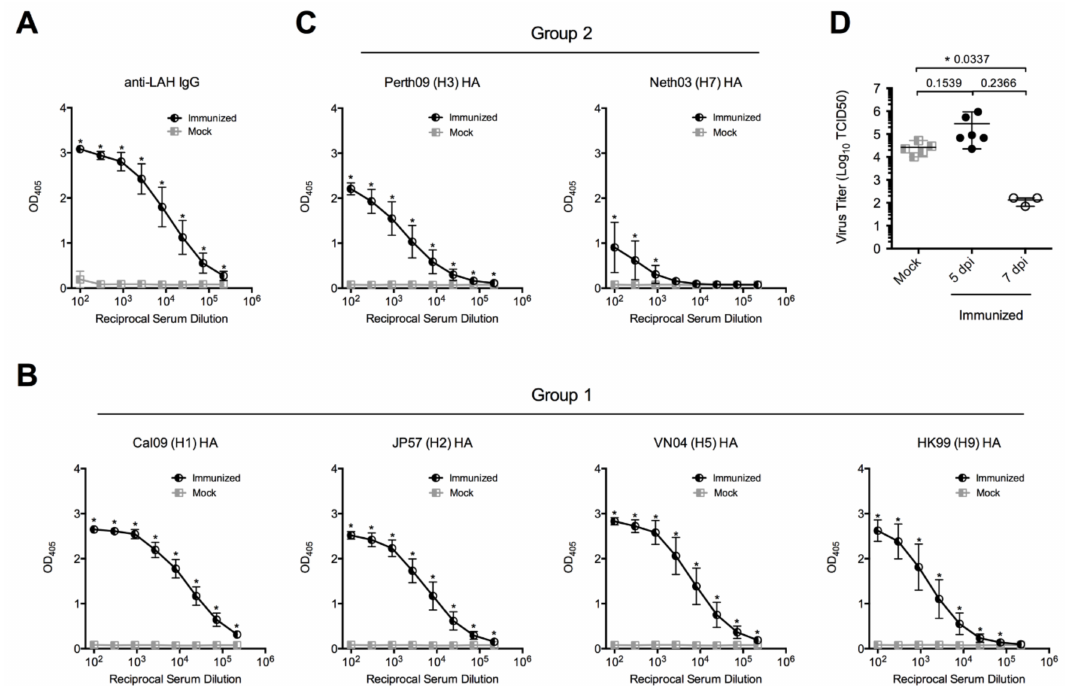
Figure 2. Seroconversion elicited by vaccination. Serum reactivity with synthetic long alpha helix (LAH) peptide ( A ), with group 1 HA proteins H1, H2, H5 and H9 ( B ) and with group 2 HA proteins H3 and H7 ( C ). ( D ) Lung virus titers of mice five (5 dpi) and seven (7 dpi) days post infection. * p < 0.05. Error bars represent standard error of the mean